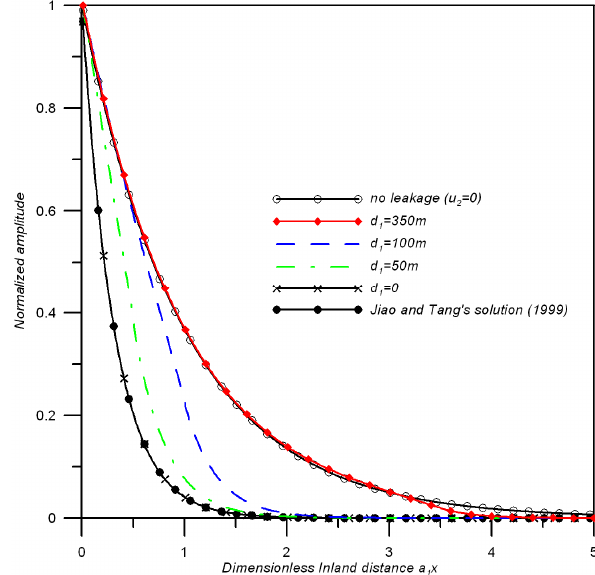
Figure 3. The curves of phase shift of the head fluctuation versus dimensionless inland 2 Fig. 3. The curves of phase shift of the head fluctuation versus distance for 5 1 = u , 0 2 = u , 2 21 101 − ×== aa m -1 , and various aquitard lengths 3 dimensionless inland distance for u 1 = 5, u 2 = 0, a 1 = a 2 = 1 × 10 − 2 m − 1 , and various aquitard lengths.